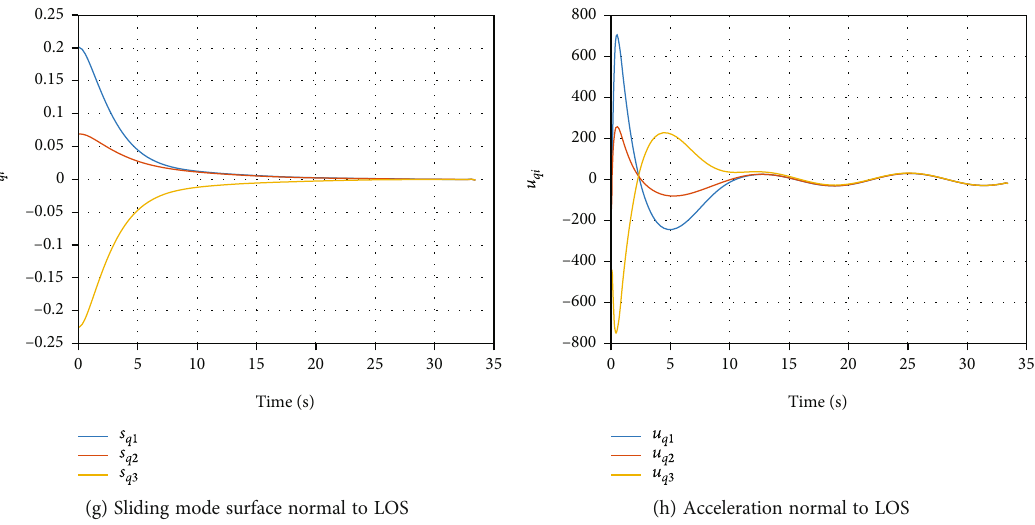
Figure 3: Response curves under FxTCG [31] for Case